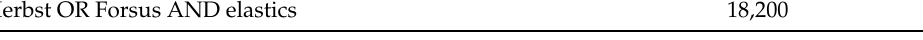
Table A7. Search strategy for Google Scholar.